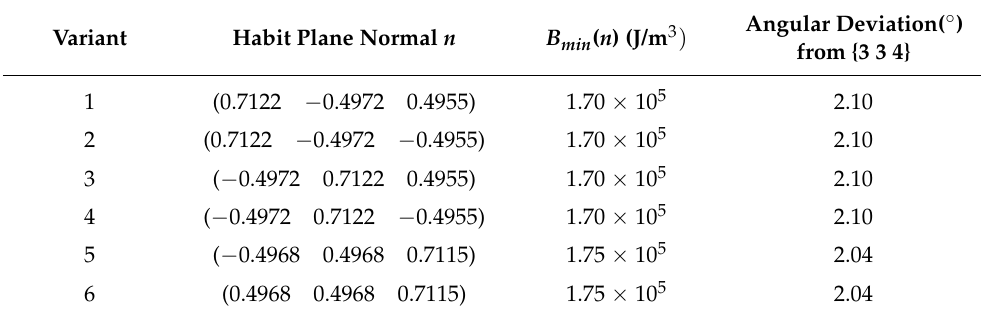
Table 8. Predicted habit plane normal, minimum B pp ( n ) and angular